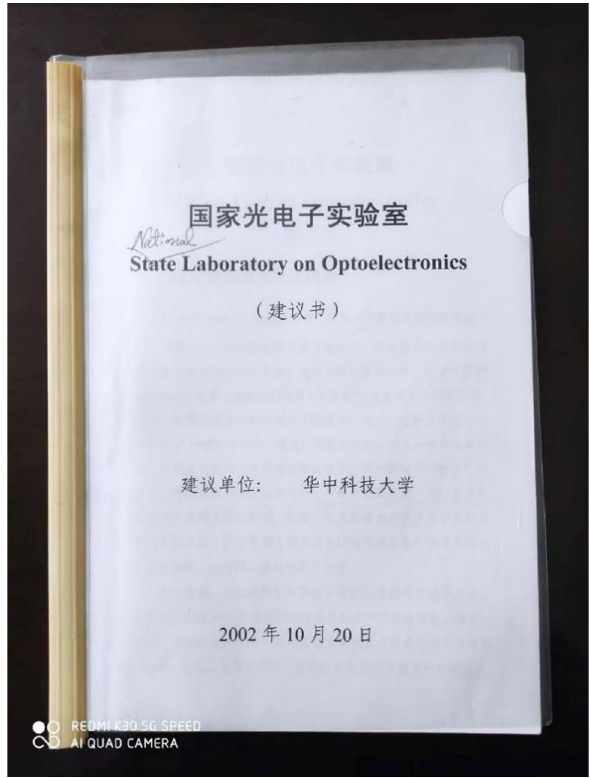
Fig. 7 Proposal for constructing Wuhan National Laboratory for